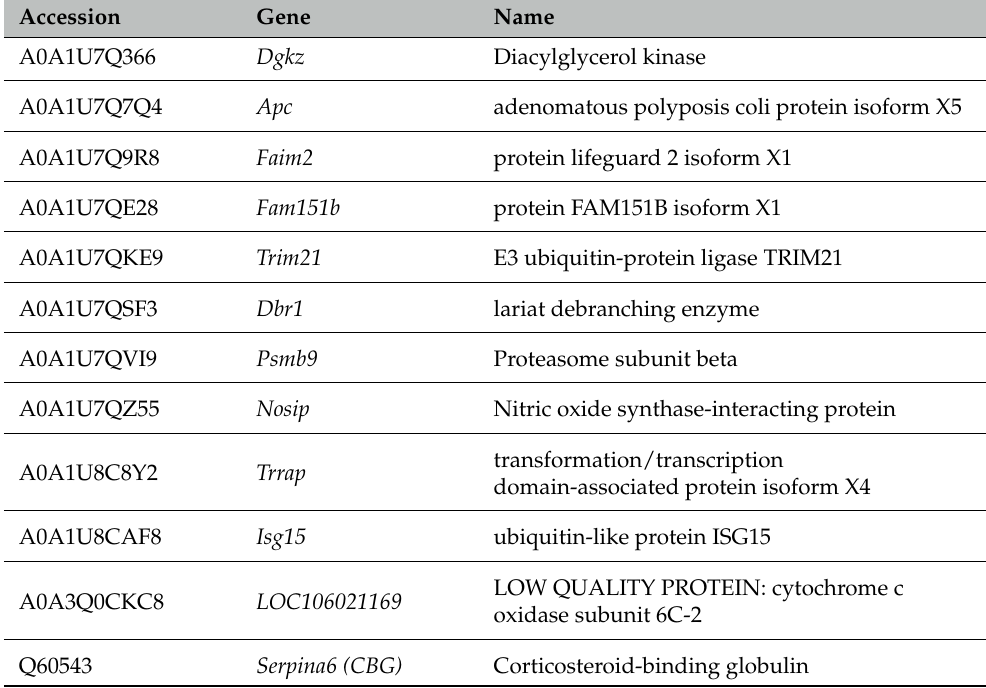
Table 3. Proteins exclusive to the IC of the GASH/Sal